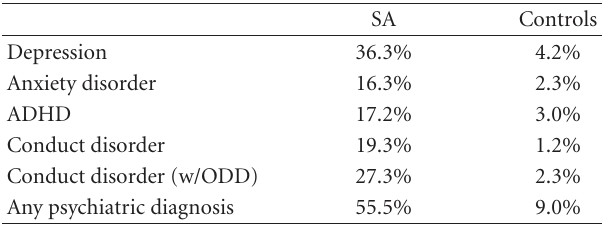
Table 1: Psychiatric comorbidity in substance abuse treatment and matched controls ∗